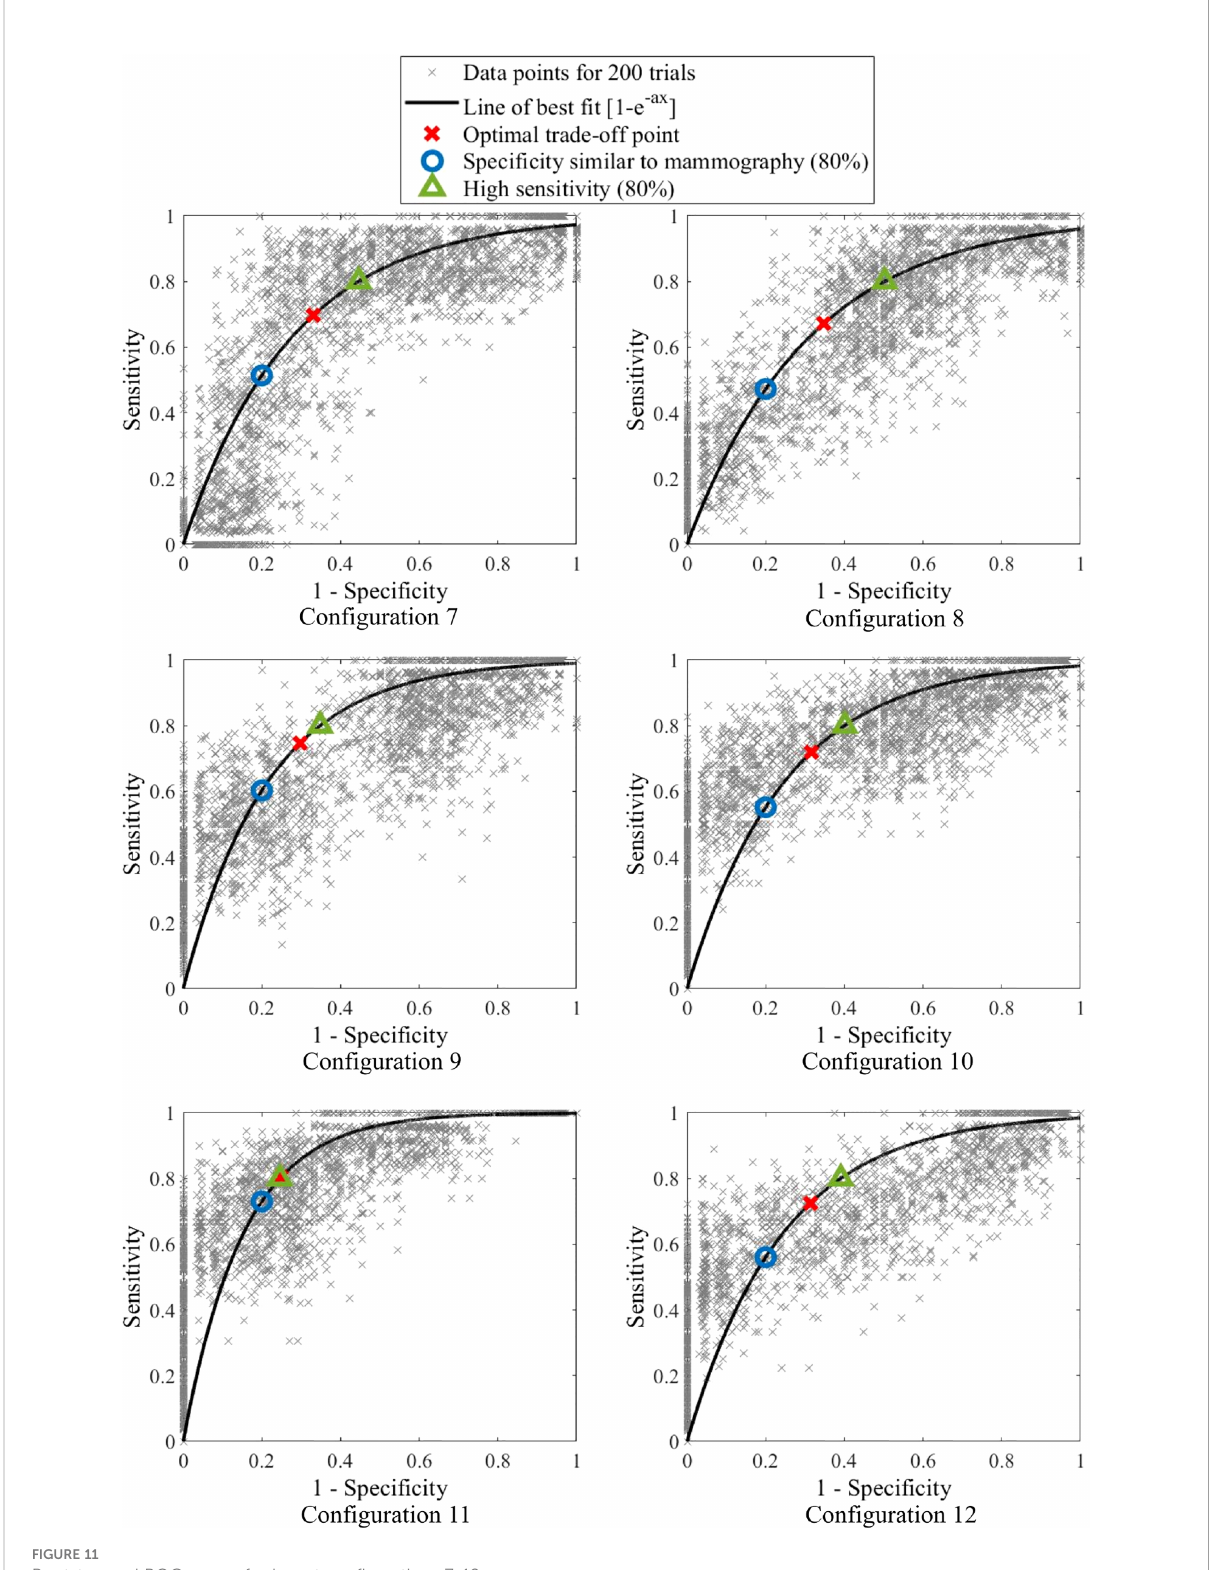
FIGURE 11 Bootstrapped ROC curves for breast con fi gurations